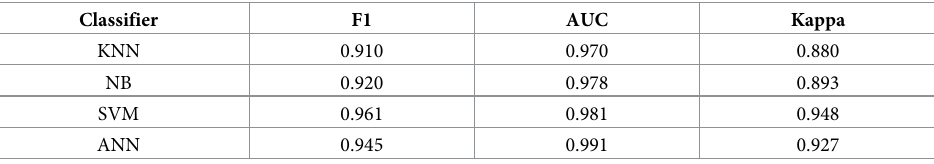
Table 3. Performance of considered classifiers using F1, AUC and Kappa metrics on the test